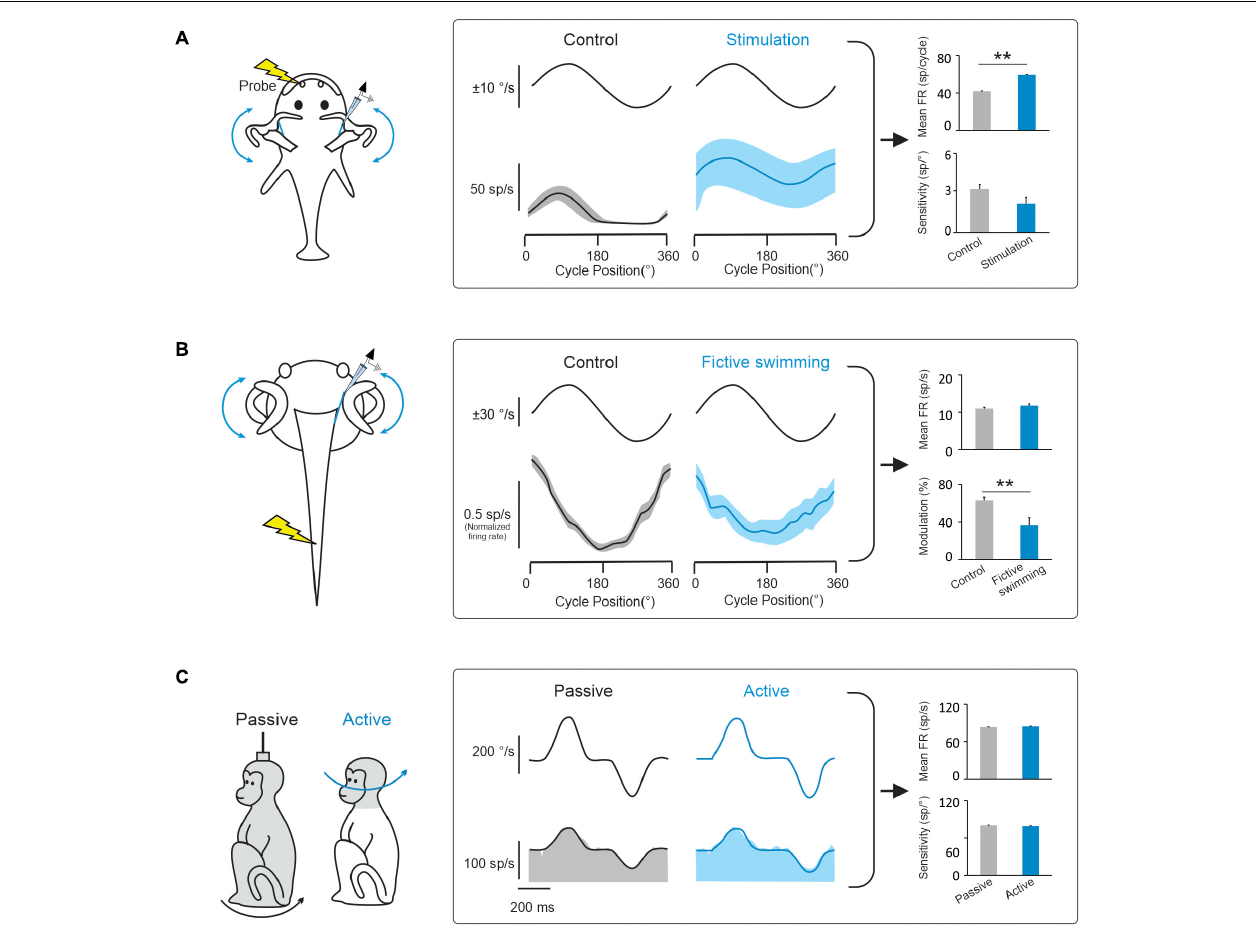
FIGURE 3 | Behaviorally-dependent efferent-mediated responses have been reported in fish and amphibians but not in mammals. (A) Left: Inducing a behavioral escape response in a head fixed toadfish activates vestibular efferent neurons. Middle: Behavioral activation of efferents alters vestibular afferent responses to passive whole-body rotation in the head-restrained fish. Right: bar plots comparing effects of electrical efferent stimulation on background and rotation-induced firing of horizontal canal afferents (data replotted from Boyle and Highstein, 1990). (B) Left: Afferent recordings made in a semi-isolated in vitro anaesthetized larval Xenopus preparation, during passive whole-body rotation. Responses to this passive rotation were compared before and during bouts of fictive swimming induced via applied electrical stimulation. Middle: The induction of fictive swimming alters vestibular afferent responses. Right : Bar plots compare the effects of fictive swimming on background and rotation-induced discharges of horizontal canal afferents (data replotted from Chagnaud et al., 2015). (C) Left: Afferent recordings made in rhesus monkeys during active and comparable passive head motion. Middle: Primate afferent responses are the same during active and comparable passive head motion (reviewed in Cullen, 2019). Right : Bar plots compare afferents resting rates and sensitivities in these two conditions (Cullen and Minor, 2002). Note: error bars represent SEM; ** P ≤ 0.001 (Wilcoxon signed-rank test).